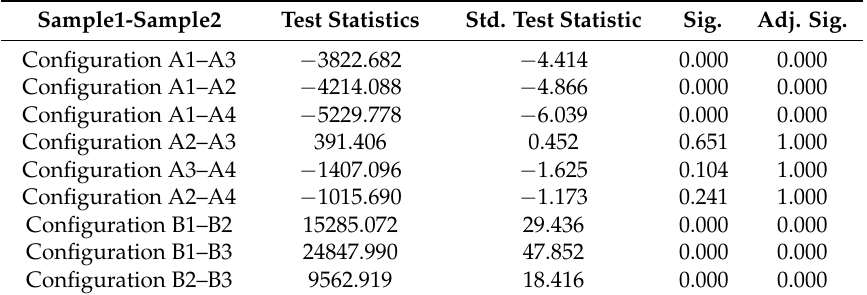
Table 21. Comparison of two parameters under different